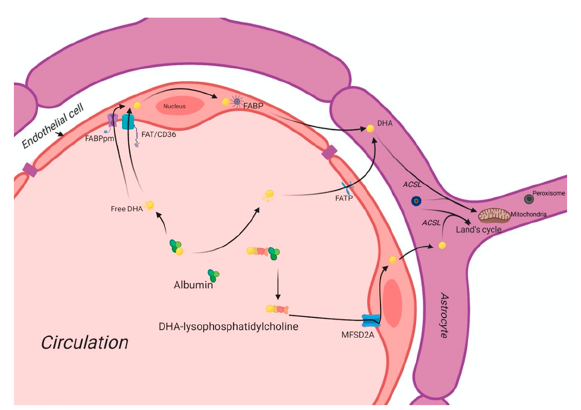
Figure 1. Docosahexaenoic acid (DHA) uptake system of the brain. DHA: Docosahexaenoic acid; MFSD2A: Major facilitator superfamily domain containing 2A; FABPpm: Plasma membrane fatty-acid binding proteins; FAT/CD36: Fatty acid translocase/cluster of differentiation 36; FABP: Fatty acid-binding protein; FATP: Fatty acid transporter protein; ACSL: long-chain acyl-CoA